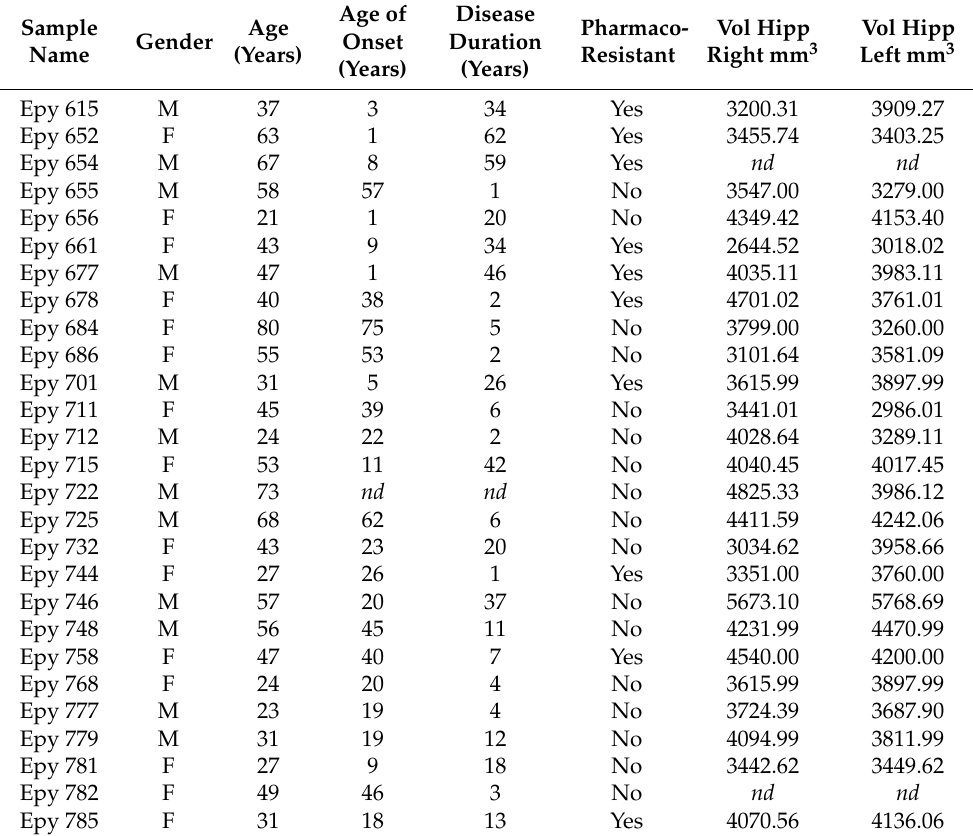
Table 1. Clinical data of temporal lobe epilepsy (TLE) patients are shown ( nd , not